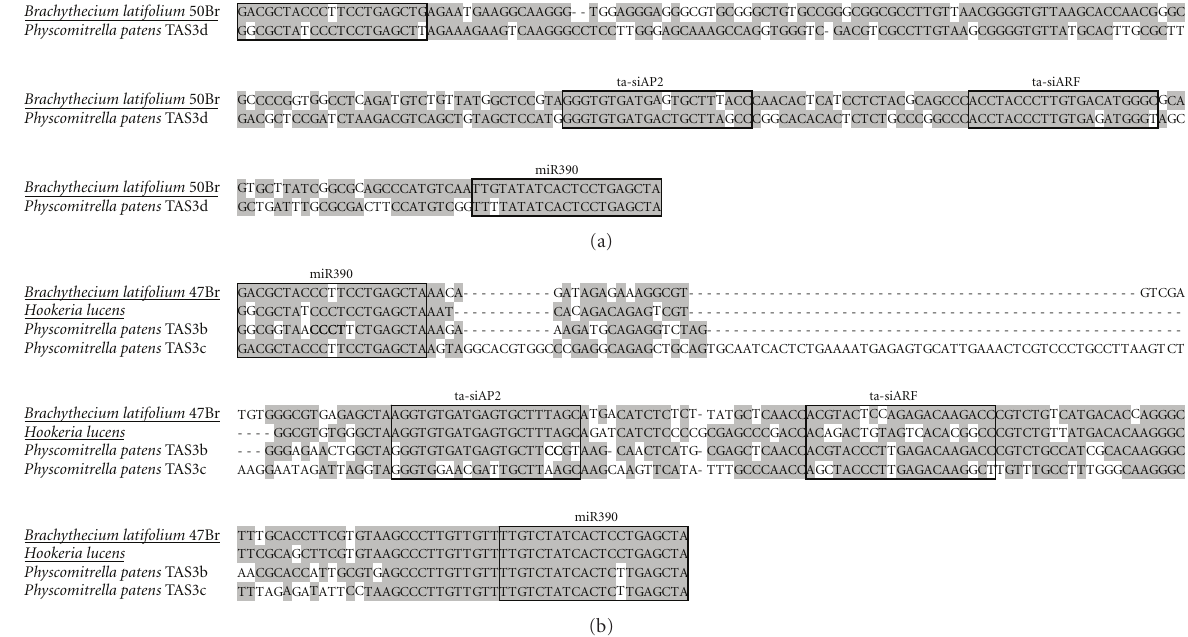
Figure 5: Nucleotide sequence alignment of ta-siARF loci of mosses. (a) Alignment of Brachythecium latifolium clone 50 Br sequence and Physcomitrella patens TAS3d. (b) Alignment of B. latifolium clone 47 Br sequence and Hookeria lucens with P. patens TAS3b and TAS3c. Sequences of B. latifolium and H. lucens (undelined) were determined in this study, the others were from GeneBank. Boxes indicate miR390 complementary sites, ta-siARF sequence regions and ta-siAP2 regions. Shading shows residues identical for the given position in most sequences. Sequences of B. latifolium and H. lucens miR390 complementary sites originate from primers used for the amplification of ta- siARF loci. GeneBank accession numbers of the sequences included in the alignment are as follows: Brachythecium latifolium clone 50 Br, FJ804747; Brachythecium latifolium clone 47 Br, FJ804748; Hookeria lucens , FJ804749; Physcomitrella patens TAS3d, BK005828; P. patens TAS3b, BK005826; P. patens TAS3c,